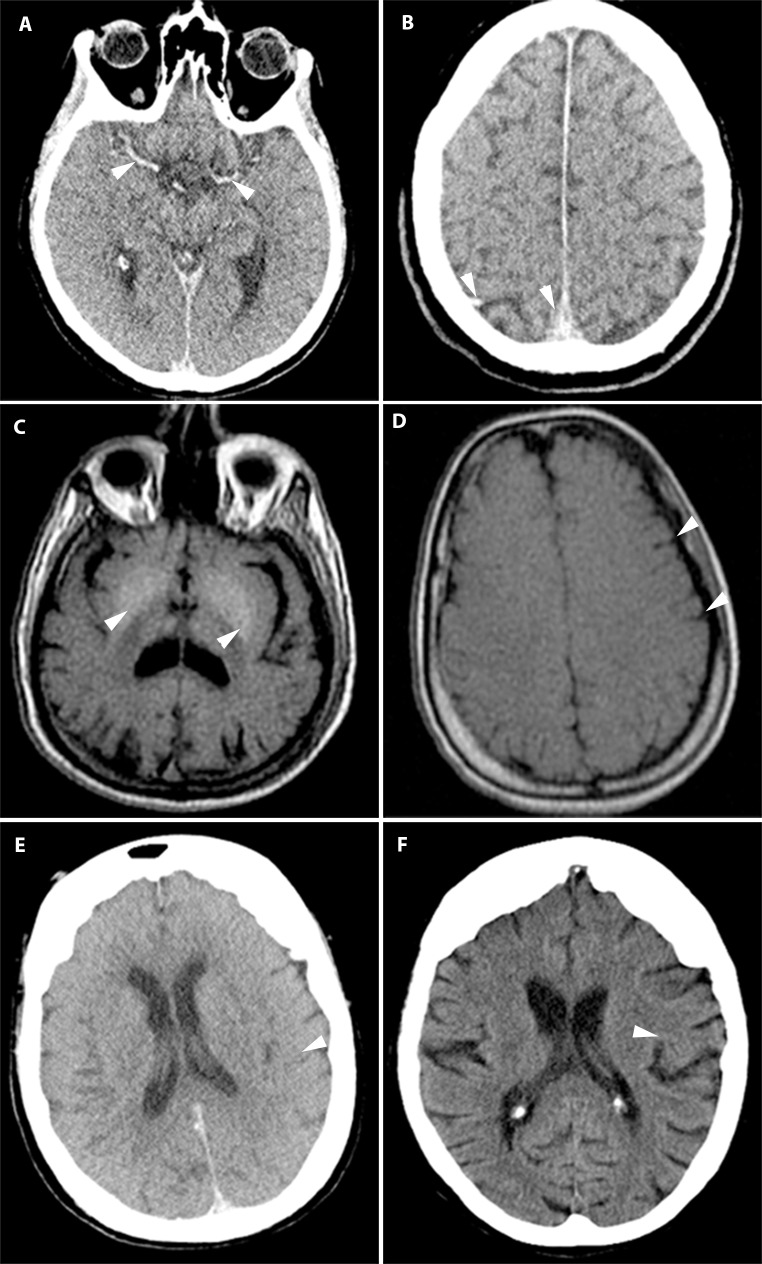
Postmortem imaging features of the brain.(A) PMCT: Symmetrical hyperdense cerebral arteries (arrowheads). (B) PMCT: Hyperdensity in the dependent cerebral veins and sagittal sinus (arrowheads). (C) T1w PMMR: High signal of the basal nuclei of the brain (arrowheads). (D) T1w PMMR: Sulcal effacement (arrowheads). (E/F) PMCT (E) and antemortem CT (F) of the same patient. The antemortem CT scan shows normal grey-white matter differentiation (arrowhead). PMCT shows complete loss of grey-white matter differentiation (arrowhead).